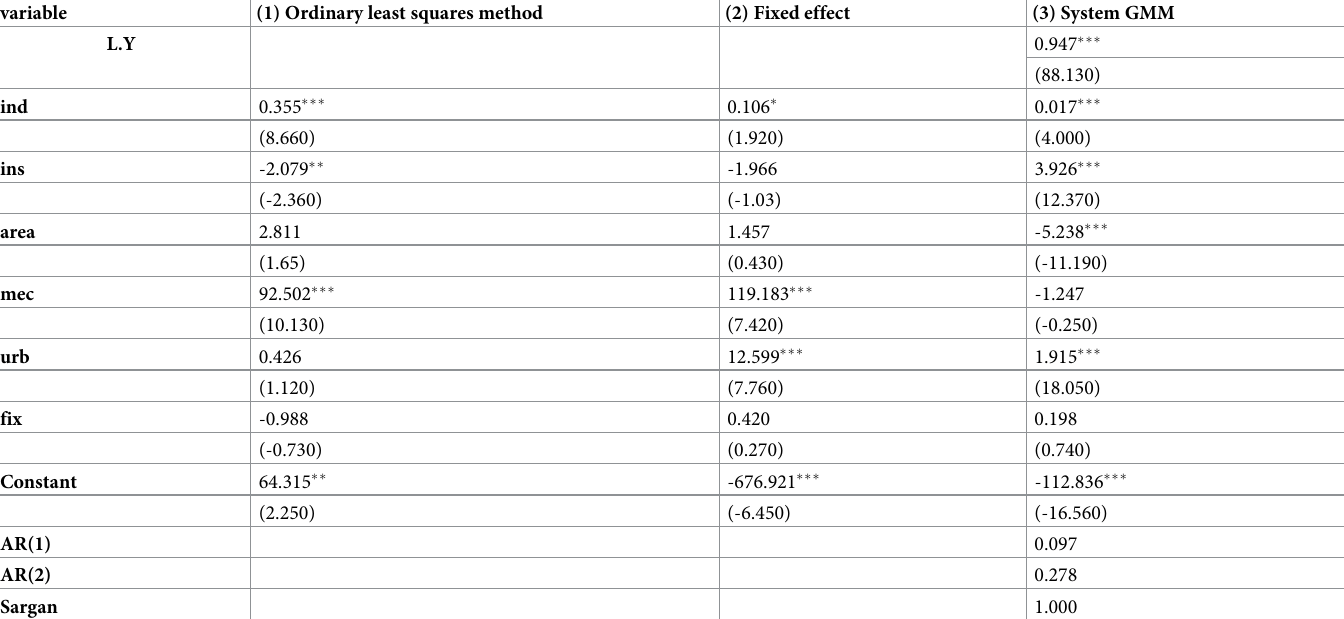
Table 5. Static and dynamic model test results of agricultural insurance direct mechanism on farmers’ income.